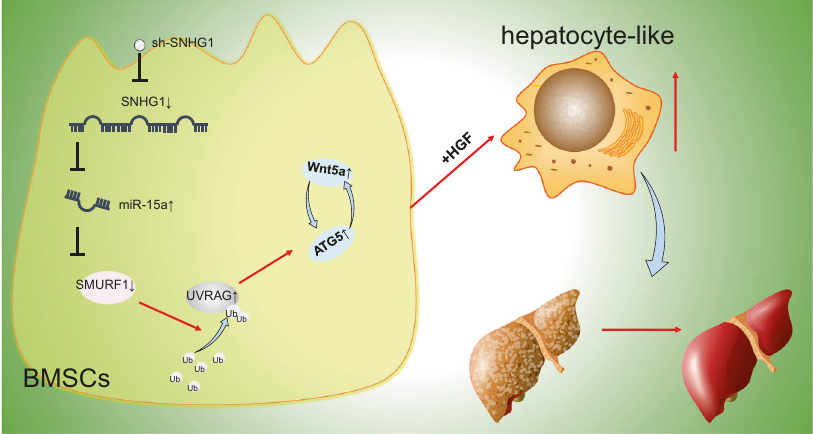
Fig. 10 Mechanism graph of lncRNA SNHG1 modulating the miR-15a/SMURF1/UVRAG/ATG5/Wnt5a axis in HLC differentiation of BMSCs and cirrhosis. shRNA-mediated lncRNA SNHG1 silencing promotes HLC differentiation of BMSCs to alleviate cirrhosis by activating UVRAG/ ATG5/Wnt5a axis via downregulation of miR-15a-targeted